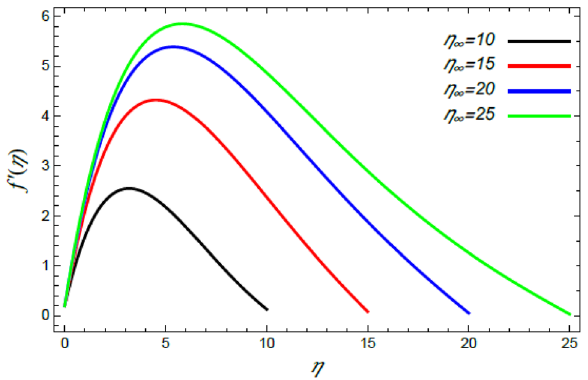
Figure 10. Variation of the radial velocity f ′ (η) versus η as given in Eq. (64) to depict the effect of η